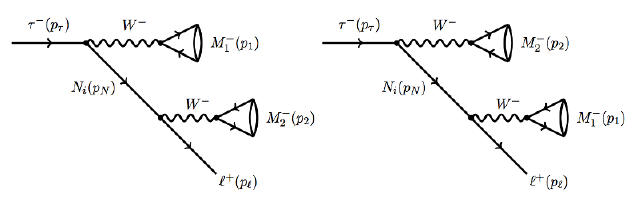
Figure 1 . Feynmann diagrams for the process (cid:28) + ! M + Right side: crossed channel C .